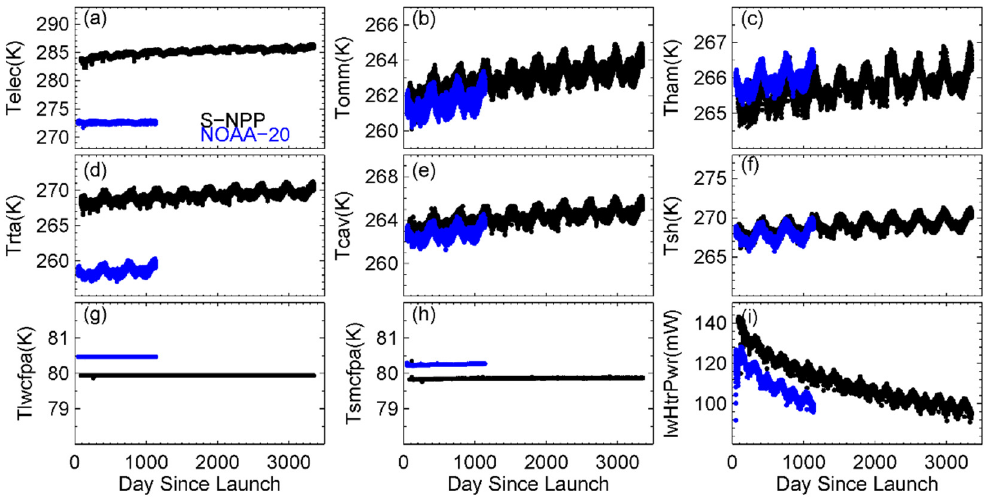
Figure 4. Time series of NOAA-20 (blue) and S-NPP (black) VIIRS instrument temperatures: ( a ) electronics (Telec), ( b ) OMM (Tomm), ( c ) half-angle mirror (HAM) (Tham), ( d ) rotating telescope assembly (RTA) (Trta), ( e ) cavity (Tcav), ( f ) OBCBB shield (Tsh), ( g ) LWIR cold focal plane assemblies (FPA) (Tlwcfpa), and ( h ) S/MWIR cold FPA (Tsmcfpa), as well as ( i ) longwave heater power (lwHtrPwr).